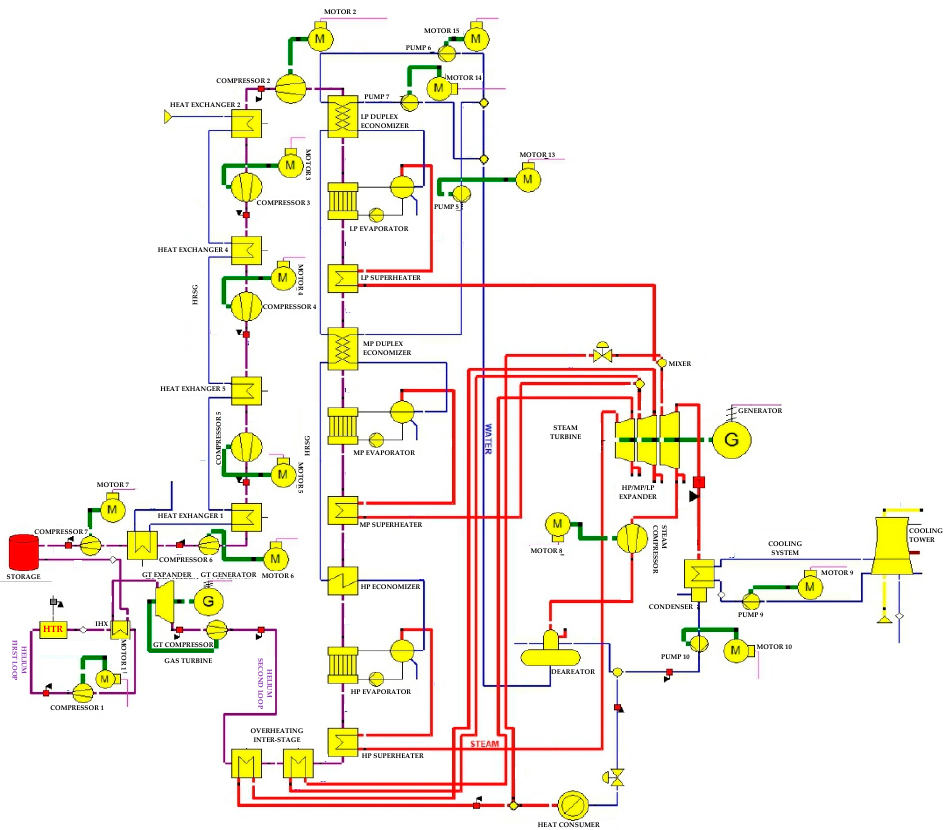
Figure 1. The HTR coupled with a gas turbine combined cycle and with 3P-HRSG unit.